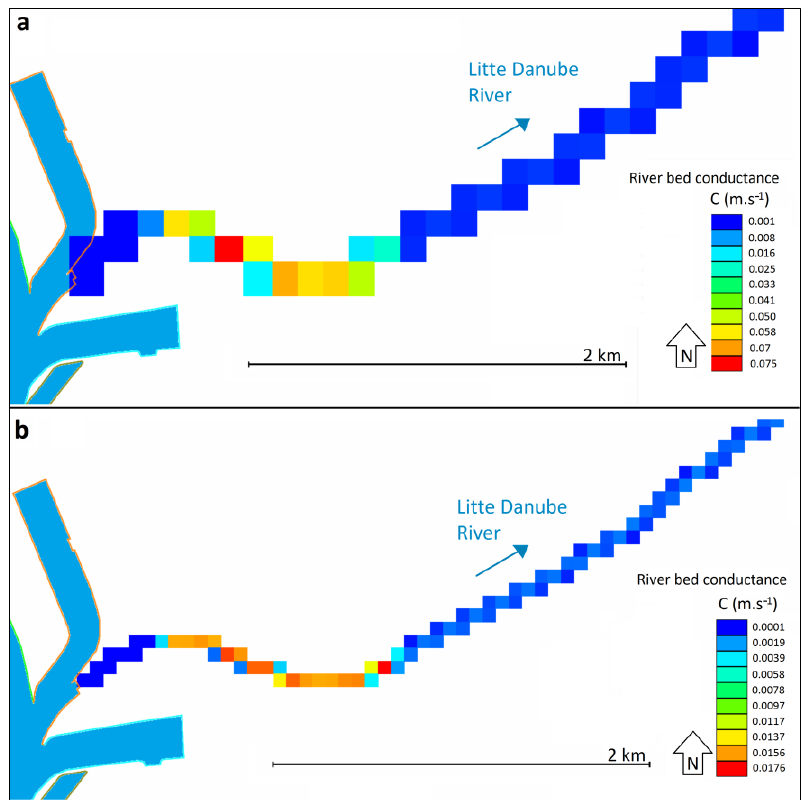
Figure 8. Optimized Little Danube riverbed conductance (C) within V3 ( a ) and V4 ( b ) model vari-